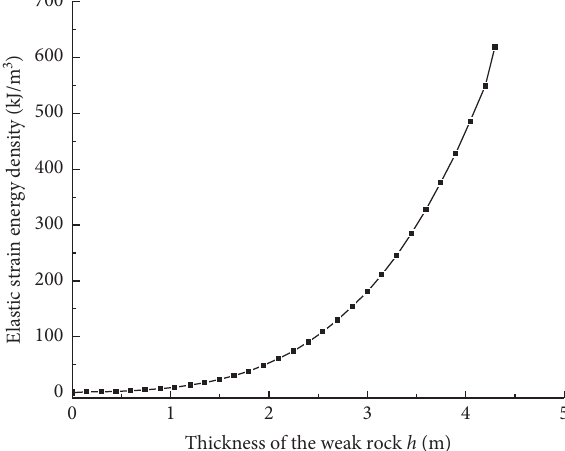
Figure 5: Curves of the elastic strain energy density for different values of weak rock